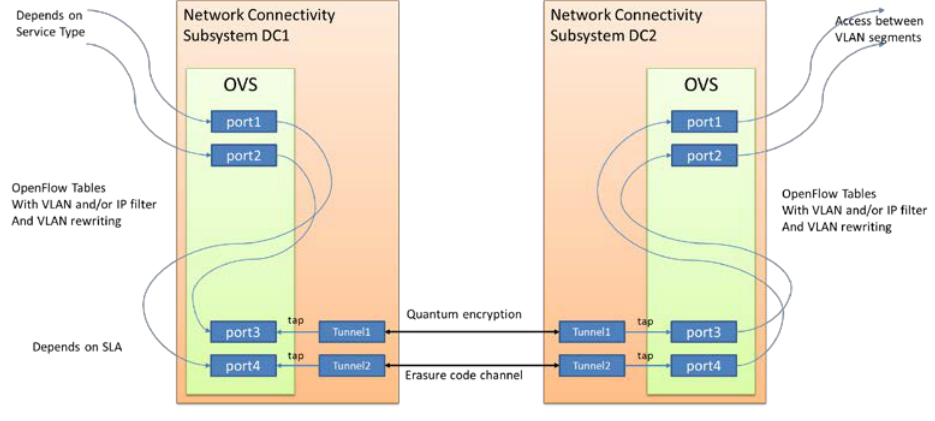
Fig. 6. Connectivity